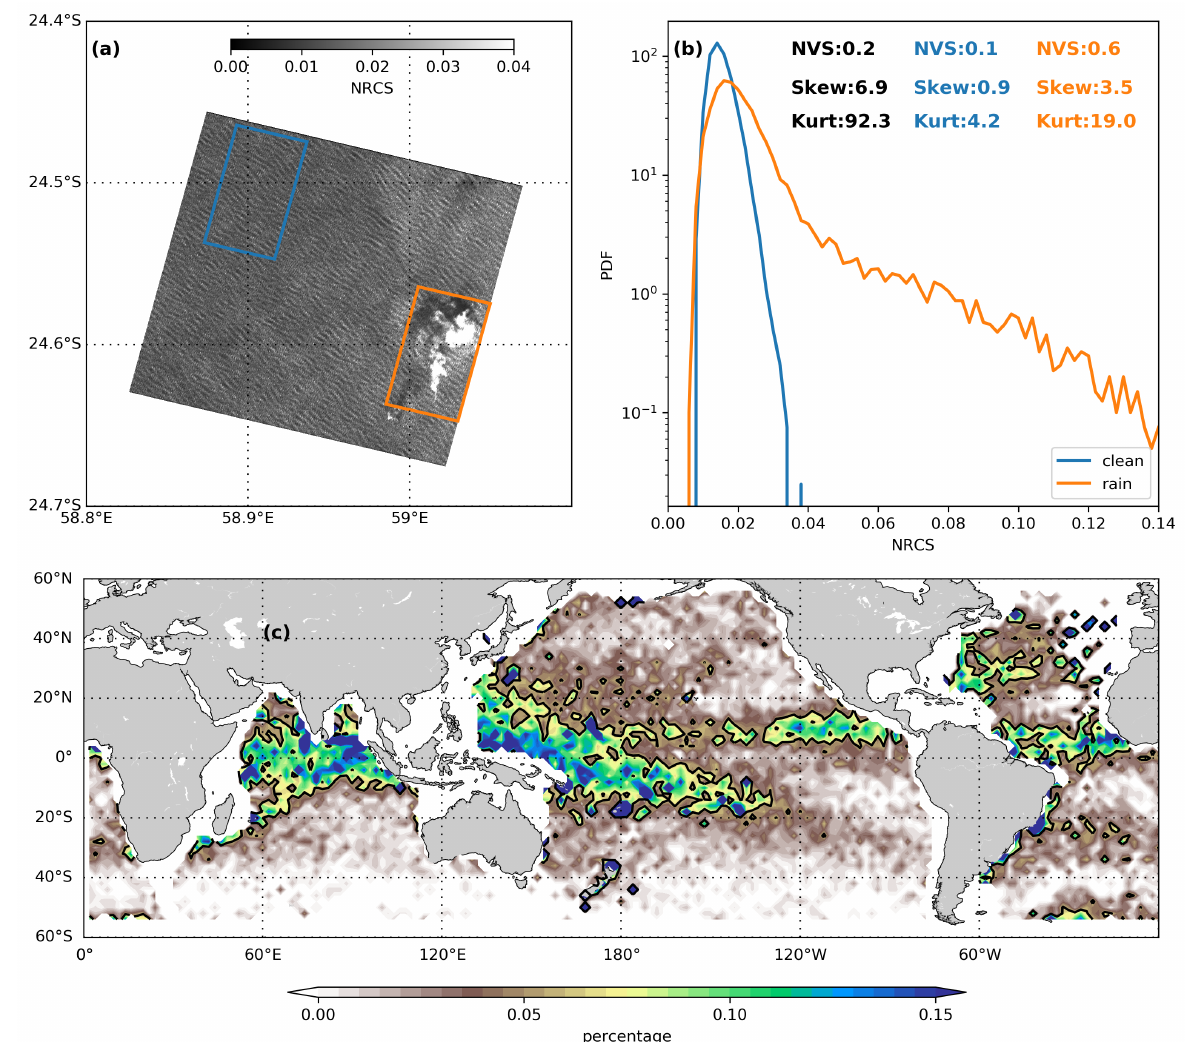
Figure 7. ( a ) A SAR NRCS image labeled as rain cells acquired by WV2; ( b ) the NRCS PDFs over the area of interest marked by the rectangles in colors as well as the entire SAR image (black curve). The three statistical parameters are accordingly annotated in the plots. ( c ) The global percentage map of the detected rain cells based on the kurtosis criteria for